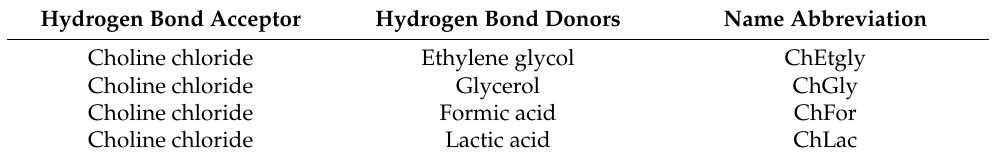
Table 1. Information of synthesized DESs.